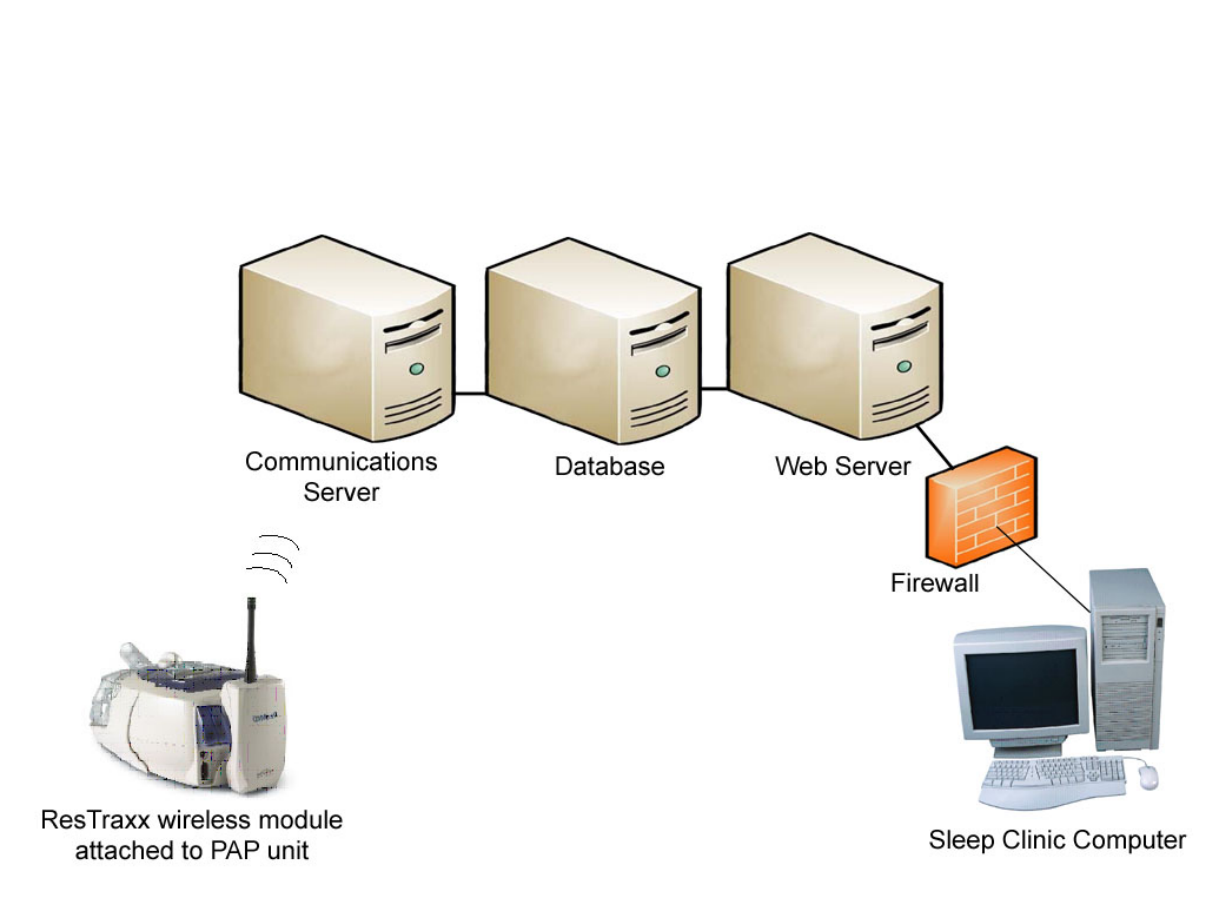
Figure 2. Model of wireless telemonitoring of CPAP compliance and